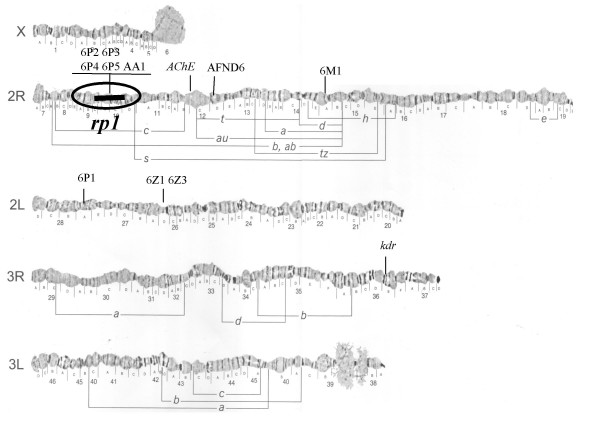
Cytogenetic map of An. funestus polytene chromosomes indicating rp1 QTL position and P450 genes and insecticide target site genes, physically mapped by in situ hybridisation during this study. This figure is adapted from [39].